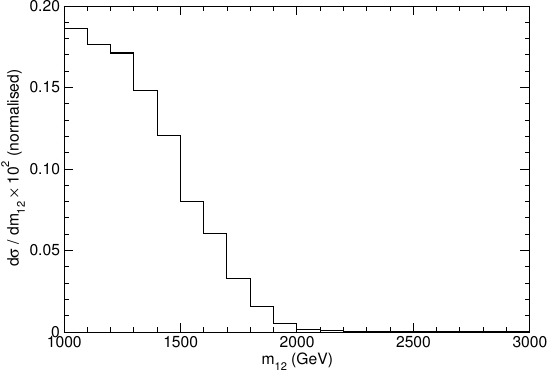
Figure 5 . Sample diboson invariant mass distribution m 12 for a R ! Y 1 Y 2 ! V 1 V 2 XX quadriboson signal at the partonic level, normalised to unity.